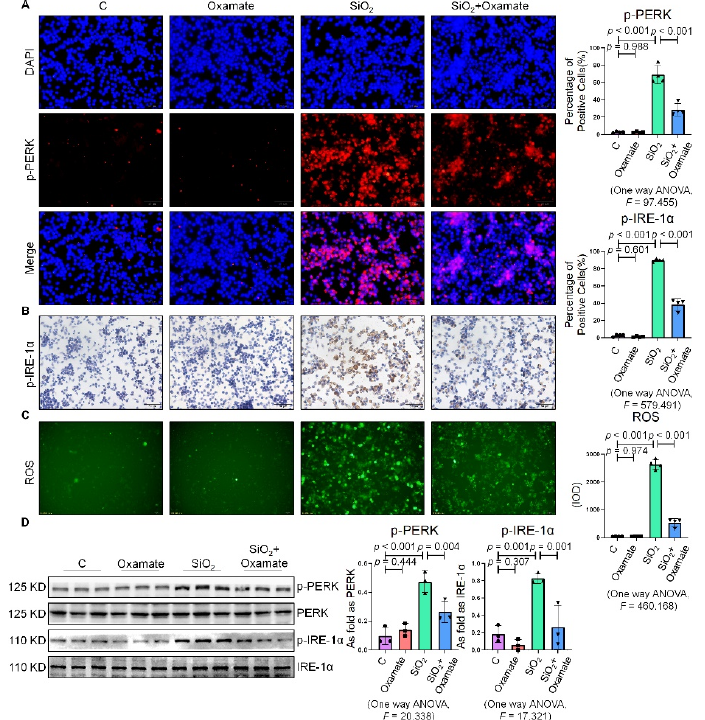
Figure 2. Oxamate attenuated the enhancement of ER stress in silica-induced macrophages. ( A ) Expression of p-PERK in NR8383 cells observed by IF staining (scale bar = 50 µm). ( B ) Expression of p-IRE-1 α in NR8383 cells observed by IHC staining (scale bar = 50 µm). ( C ) Intracellular ROS production in NR8383 cells observed by DCFH-DA staining (scale bar = 100 µm). ( D ) Protein expression of p-PERK and p-IRE-1 α in NR8383 cells treated with oxamate, SiO 2 , and SiO 2 plus oxamate measured by Western blotting. Data are presented as the mean ± SD, n = 3 per group.